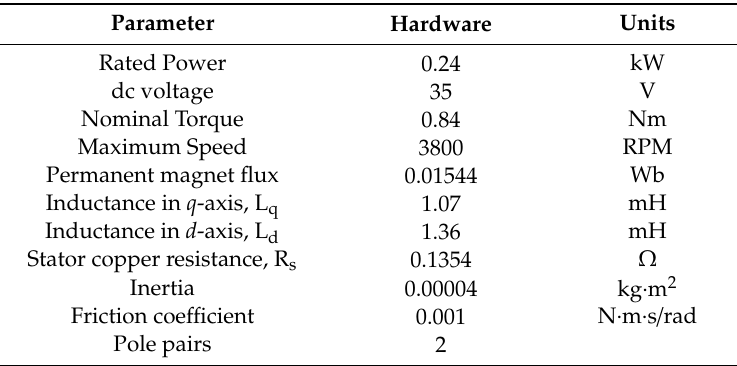
Table 1. IPM Data Used in Experimental